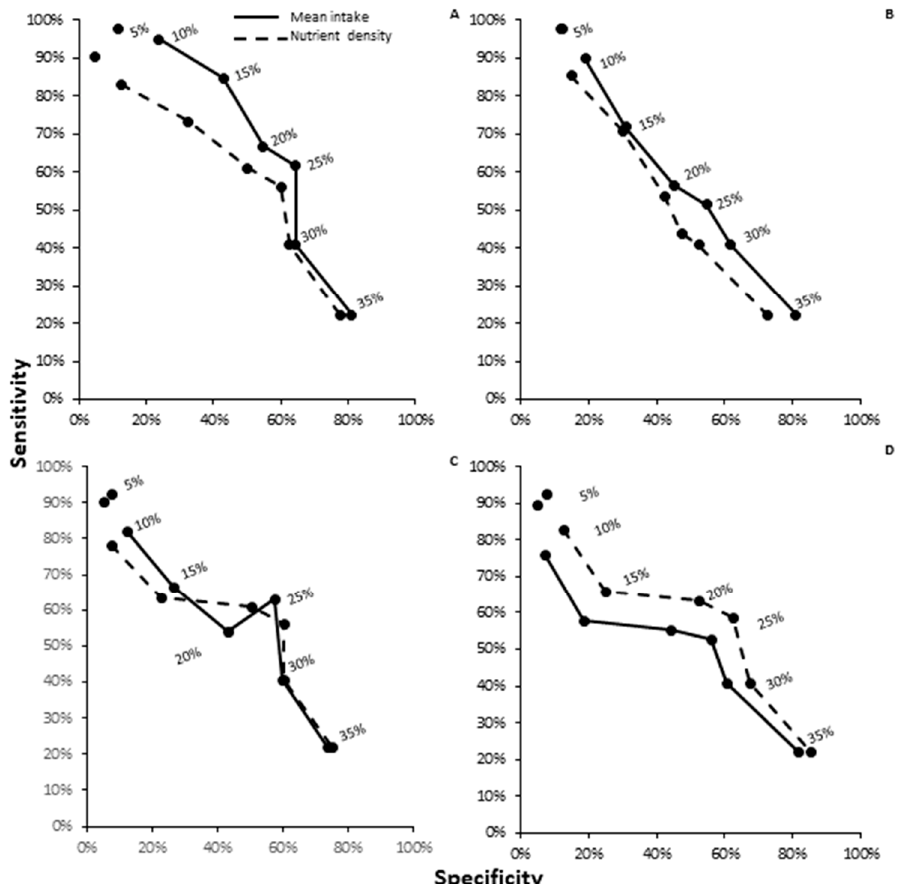
Figure 3. Receiver operative characteristic (ROC) curve for dietary assessment measurement by acute iron absorption outcomes: mean intake versus food pattern modeling for ( A ) iron, ( B ) ascorbic acid, ( C ) phytate, and ( D ) phytate–iron ratio for acute iron absorption outcomes. Nutrient density variables were inferior to mean intake assessments for estimated iron intake and acute iron absorption.